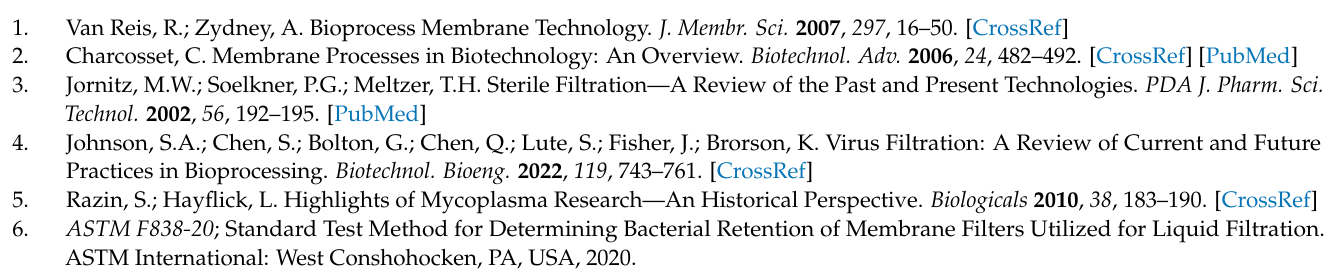
(b) filter B, Figure S3. Normalized flux versus time plot for LB broth filtration using filters A and B, Figure S4. Time versus time/volume plot for calculating maximum permeate volume (Vmax) of filters A and B, Figure S5. Filtrate flux as function of operation time at different BSA concentrations (1, 2, and 5 g/L) using (a) filter A and (b) filter B for final fill, Figure S6. Filtrate flux as function of operation time for 2 g/L of BSA solution filtration at same initial flux (approximately 10,500 LMH) with adjusted operating pressure at 1.5 bar for filter